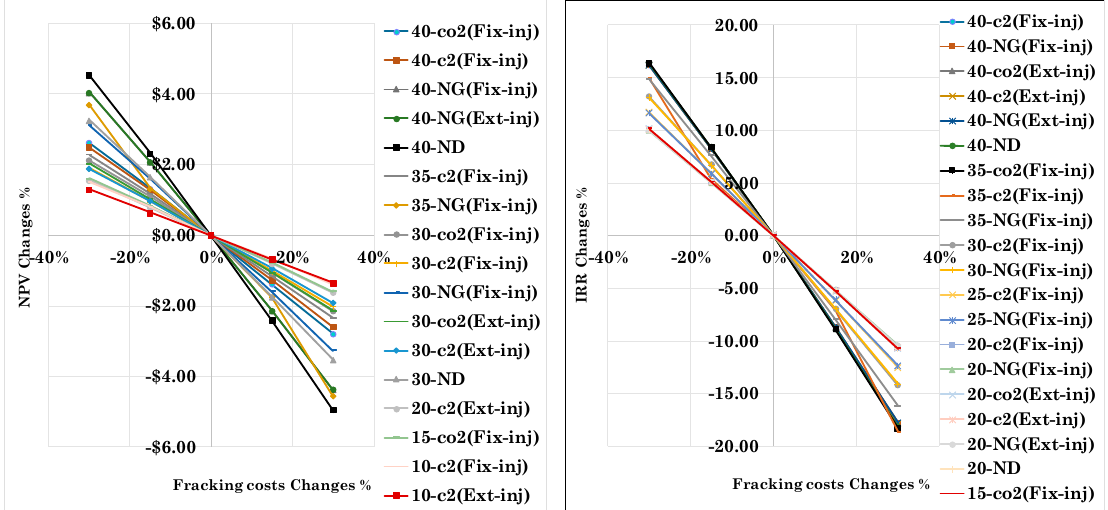
Figure 30. Changes in NPV and IRR coming from variation in fracking costs.